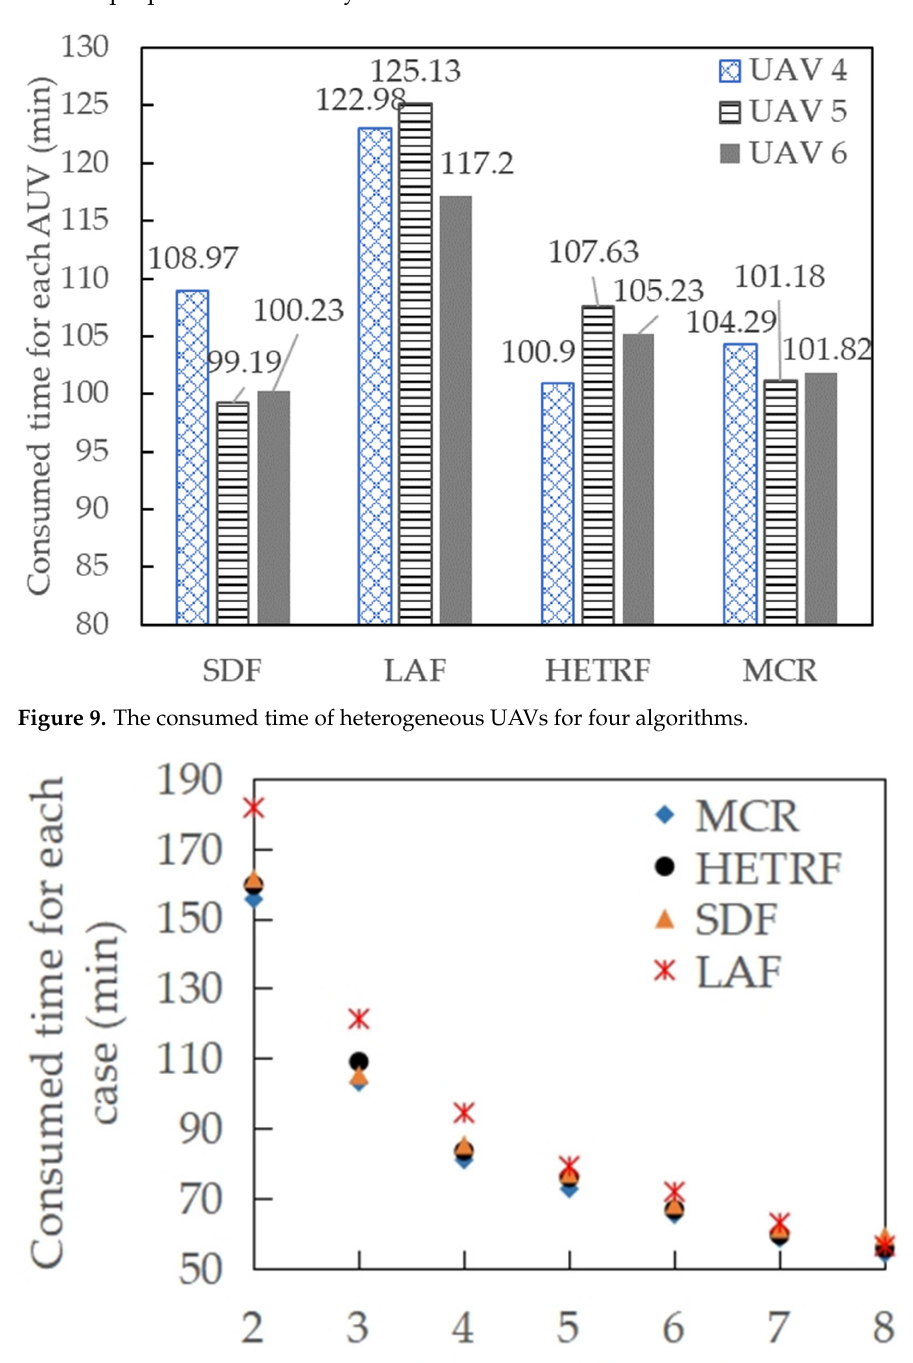
Figure 8. The CPP of heterogeneous UAVs for four algorithms: ( a ) SDF, ( b ) LAF, ( c ) HETRF, ( d ) MCR.